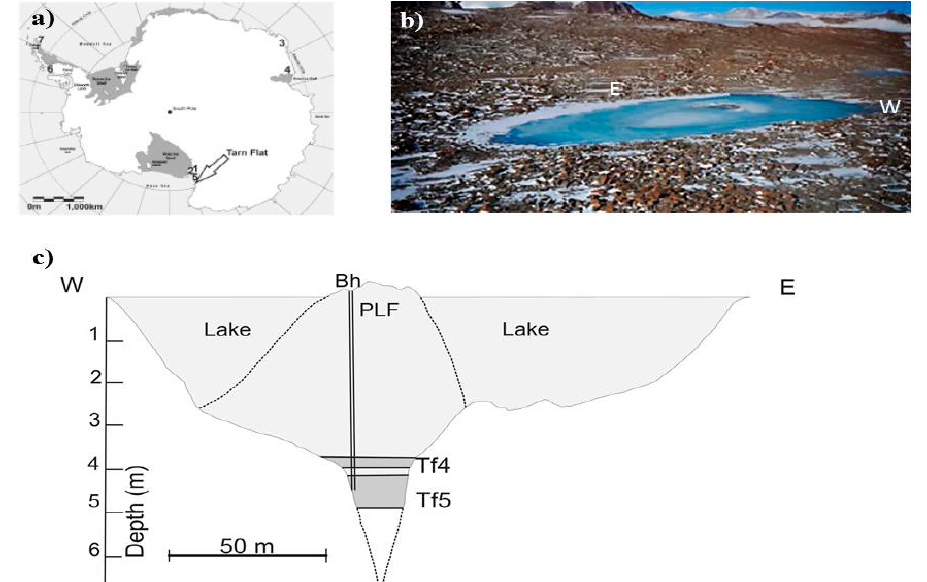
Figure 1. Study area: ( a ) Tarn Flat location; ( b ) a view of the Tarn Flat, its pingo-like feature (PLF) in the middle (photo courtesy by Michele Dalle Fratte and modified), and the extremes of the section reported in the next panel; ( c ) Lake section. Legend: light grey: lake and PLF ice; grey: hypersaline brines; dashed lines refer to the slope of PLF and the edges of the fracture located underneath the PLF deducted by GPR analyses by Forte et al. [23].